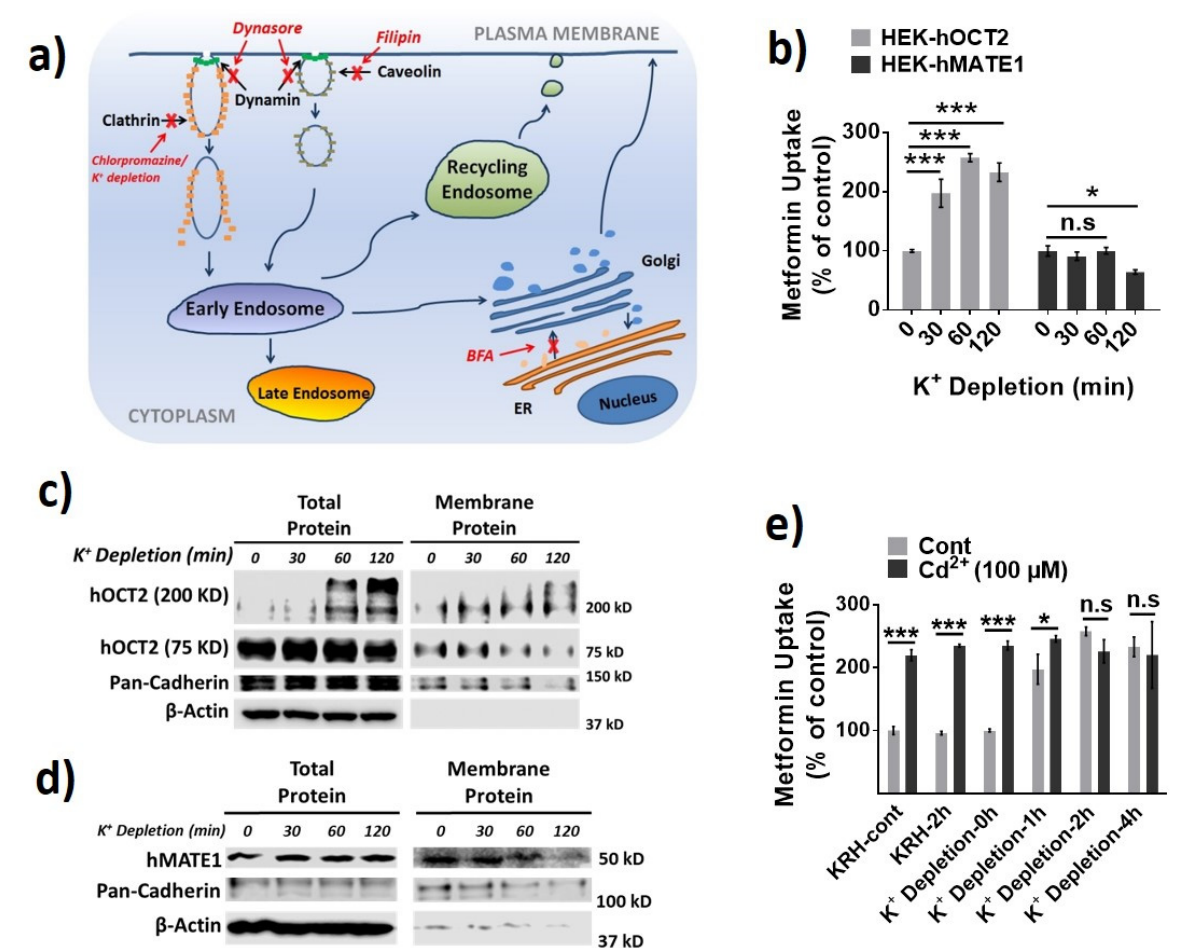
Figure 3. Effect of potassium (K + ) depletion on the membrane expression and function of hOCT2 and hMATE1. ( a ) A schematic model of the cellular protein trafficking pathways, and the mechanisms of different protein trafficking perpetrators. ( b ) Cellular uptake of metformin in HEK-hOCT2 and HEK-hMATE1 cells after exposure to K + depletion buffer at indicated times. ( c ) IB analysis of total and membrane fraction of hOCT2 in HEK-hOCT2 cells after exposure to K + depletion buffer at indicated times. ( d ) IB analysis of total and membrane fraction of hMATE1 in HEK-hMATE1 cells after exposure to K + depletion buffer at indicated times. ( e ) Cellular uptake of metformin in HEK-hOCT2 cells with and without Cd 2+ treatment for 20 min after being exposed to K + depletion buffer at indicated times. For c and d, pan-cadherin served as the positive control and β -actin as the negative control for membrane proteins. For b and e, data are presented as mean ± S.D.; * p < 0.05, *** p <